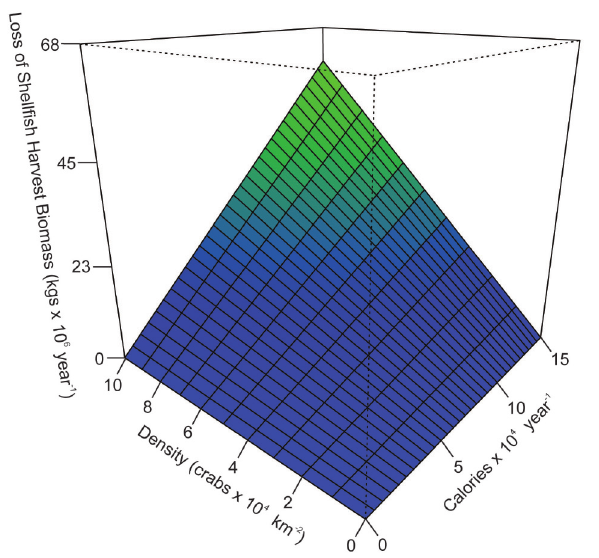
Figure 4. Sensitivity analysis of the loss of shellfish harvest biomass. Loss of shellfish harvest biomass (kg year -1 ) as a function of calories consumed each year and the density of C. maenas km -2 in harvest areas. Assumes 60% to 100% of green crab diet is made up of hardshell clams, oysters and